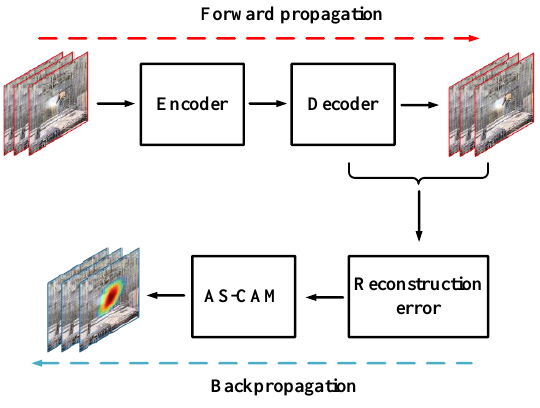
Figure 3. Flowchart of AS-CAM.